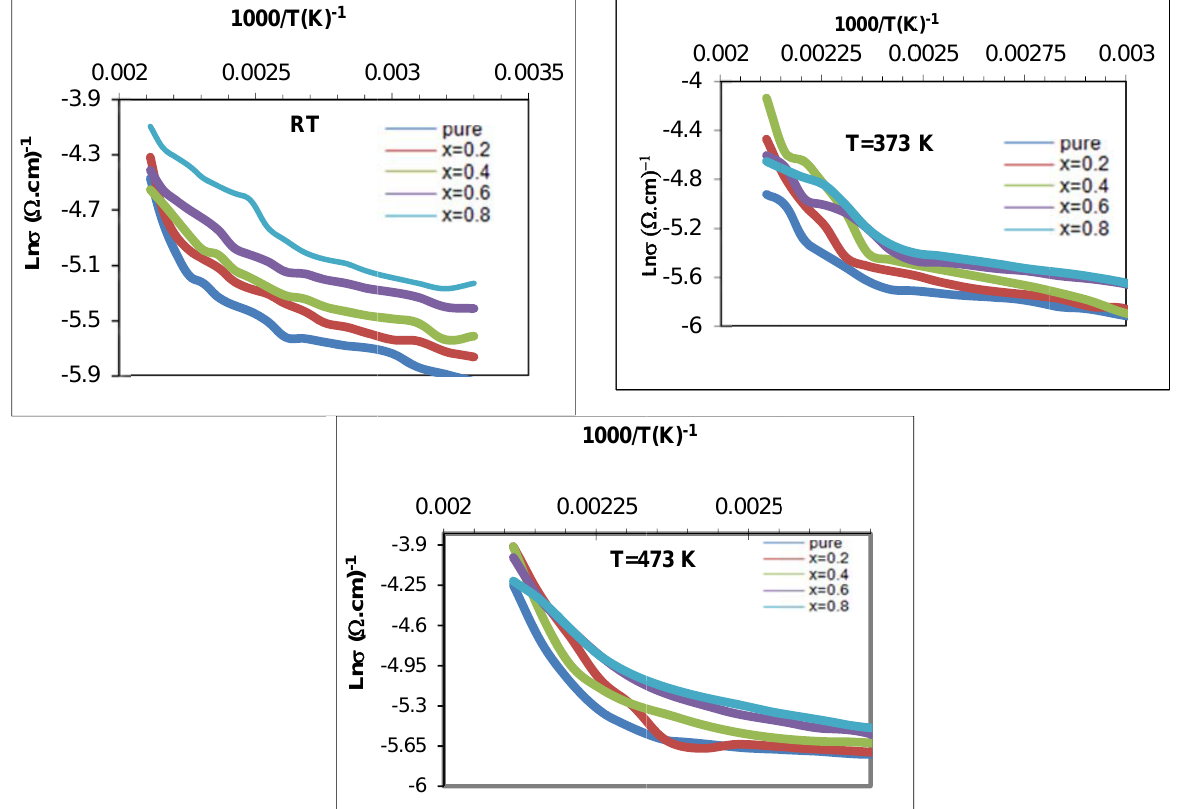
Fig. 2: Ln σ d d.c versus